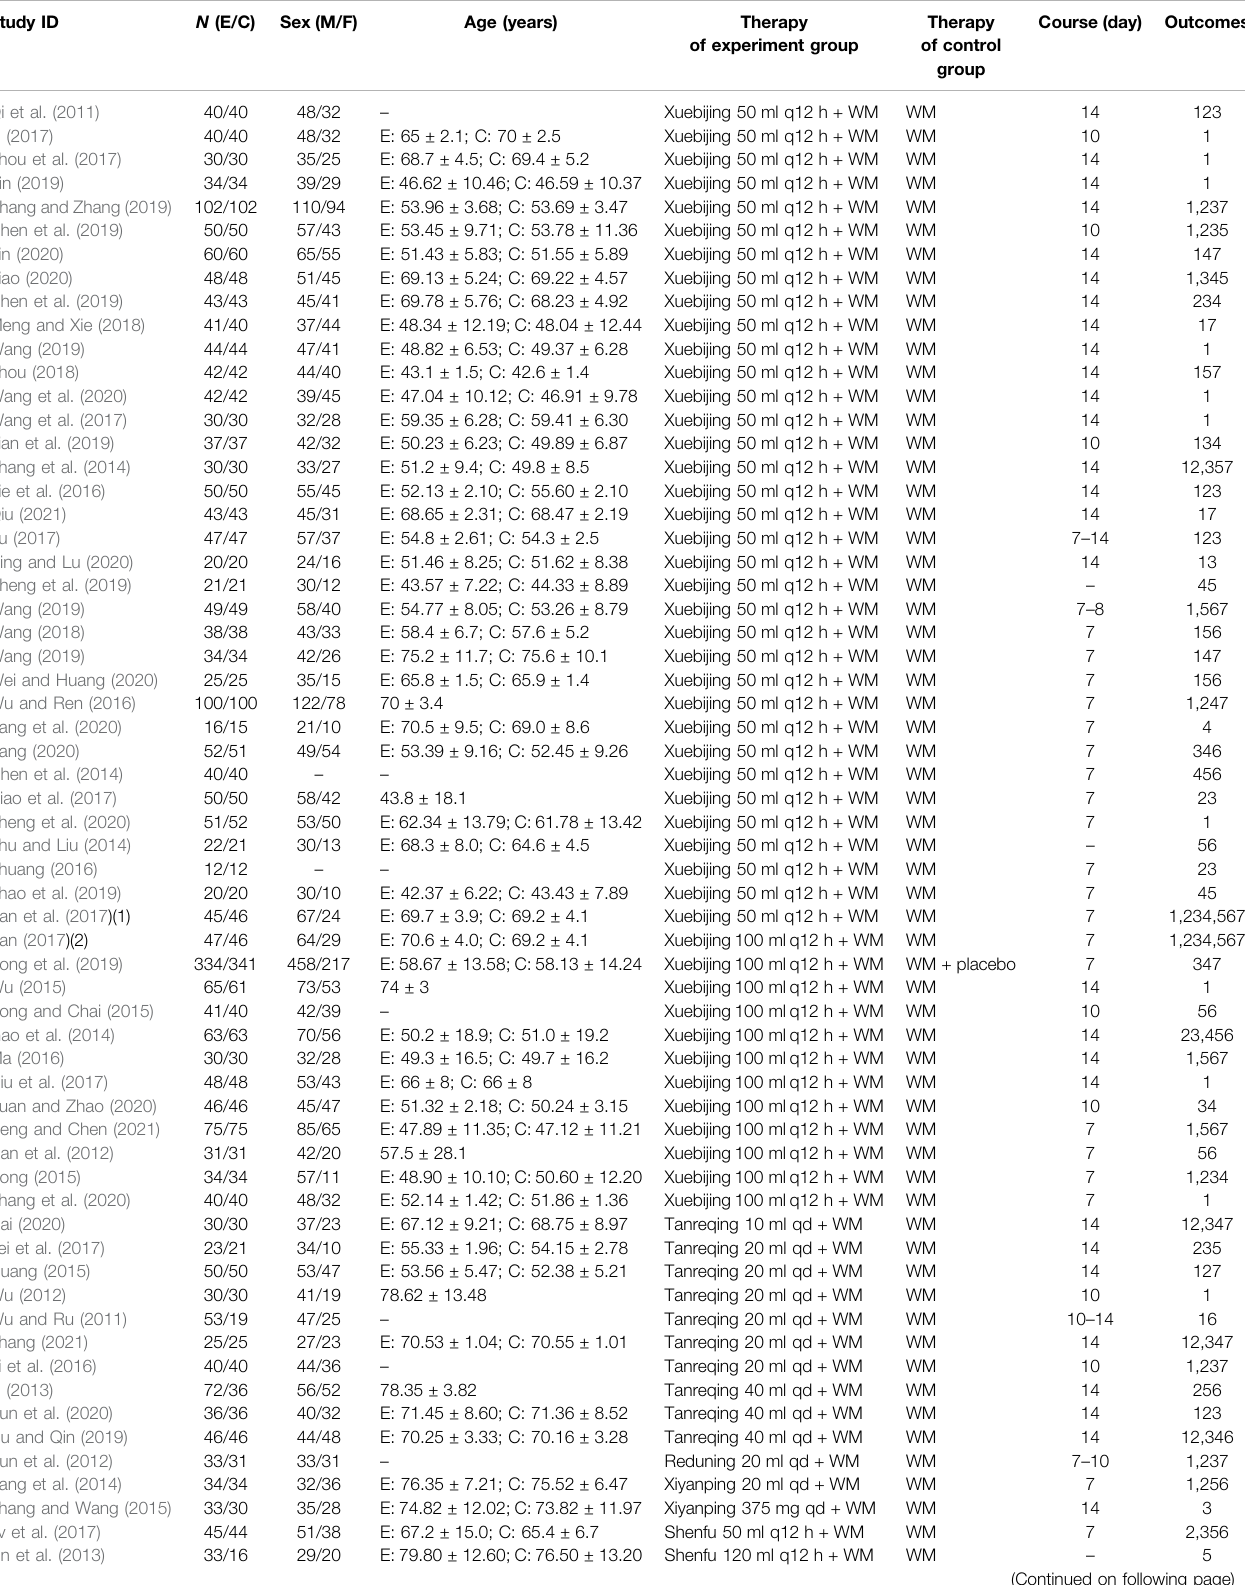
TABLE 1 | Characteristics of the studies included in this meta-analysis. Study